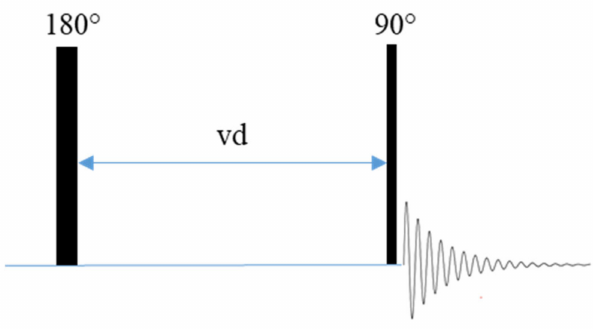
Figure 7. Inversion recovery pulse